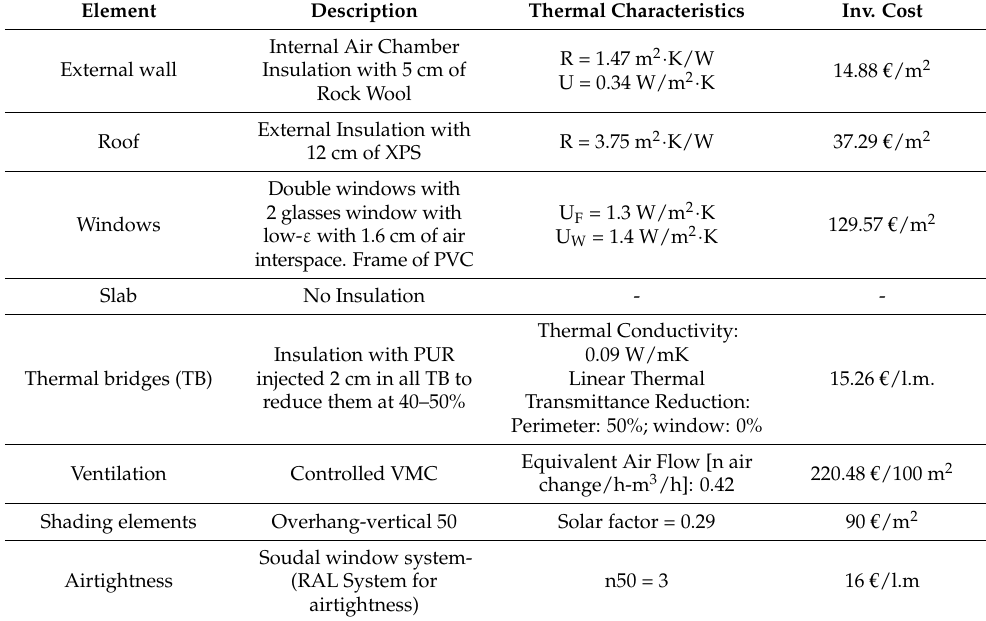
Table A8. POS10: Renovation measures of solution 5.